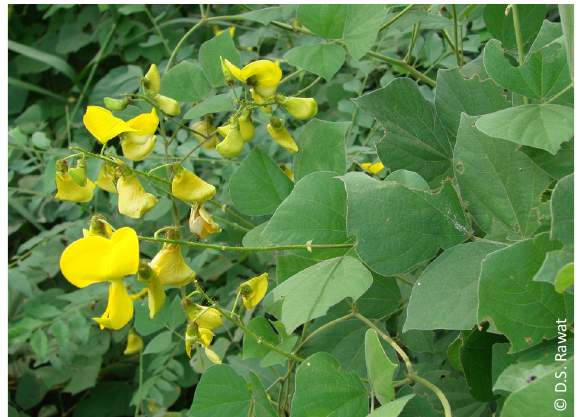
Image 3. Dunbaria glandulosa ( Dalz.) Prain